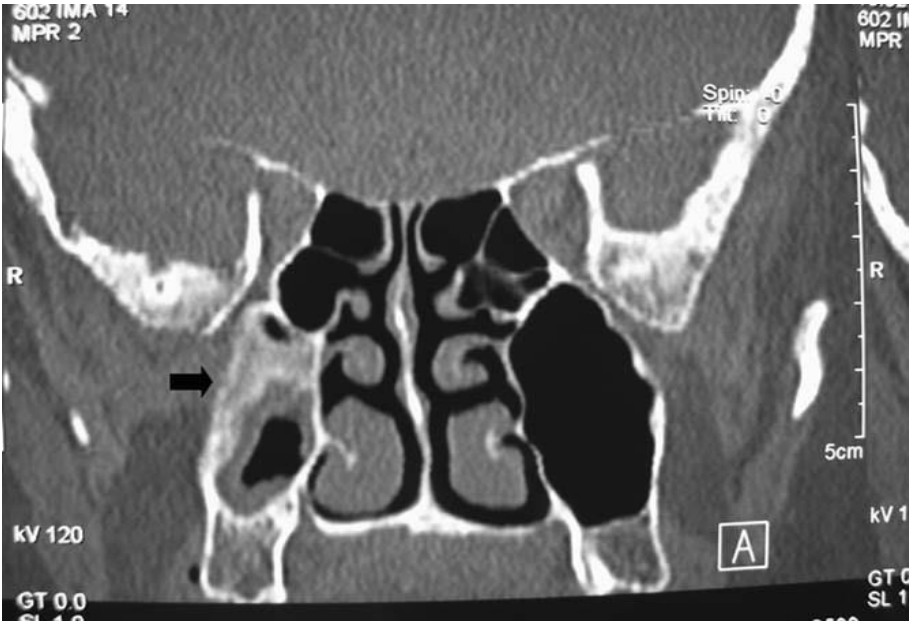
Figure 2. Coronal image of computed tomography showing a recurrent sinonasal inverted papilloma pedicled on the posterior maxillary sinus wall. There is significant hyperostosis at the origin of the lesion.